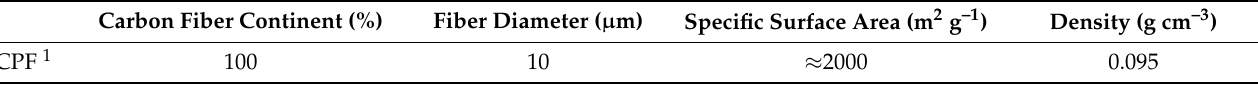
Table 3. Characteristics of adsorbent material